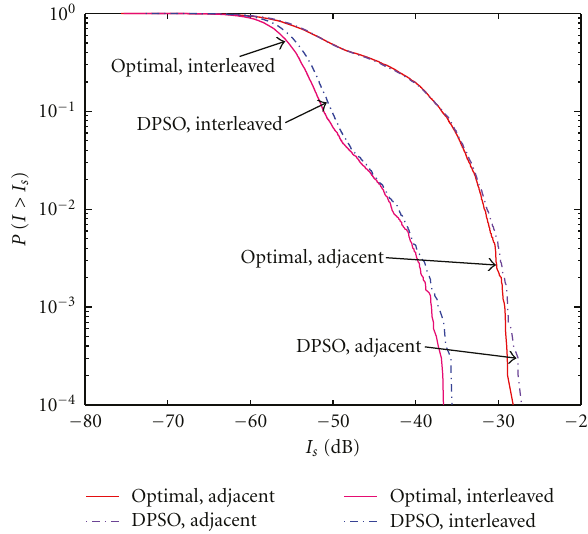
Figure 10: Optimal PTS-AIC and DPSO PTS-AIC N b = 4, N w = 8. P = 30, Q = 20.